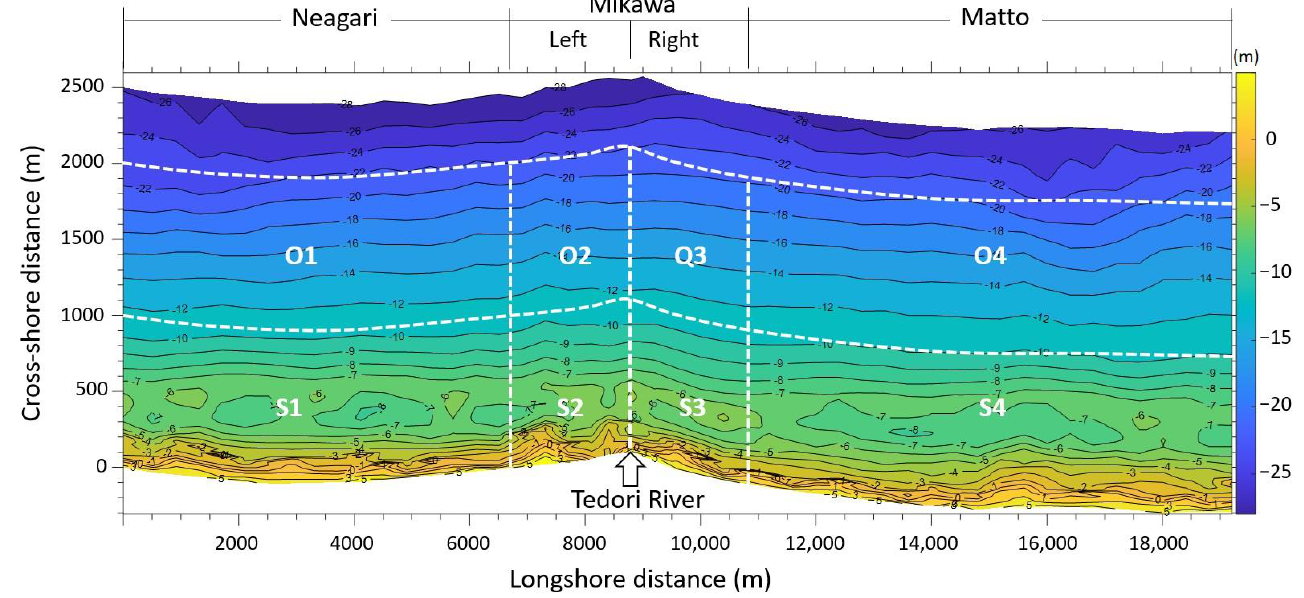
Figure 3. Bathymetric map of the study area in Ishikawa coast area, along with the average bed elevation during 1996 – 2017. The orange ticks illustrate all 49 survey lines, with an average distance between them of 400 m in the longshore direction.